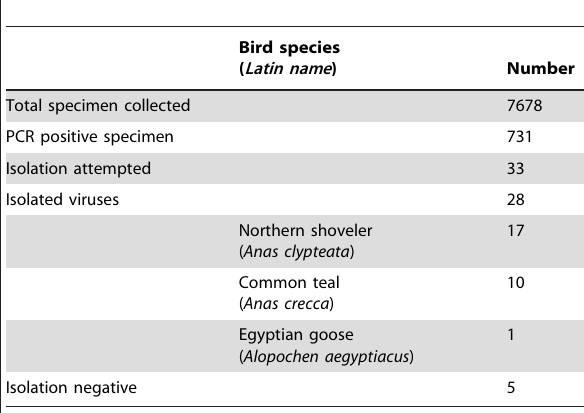
Table 1. Number of influenza A virus PCR positive specimen and number of embryonated chicken egg